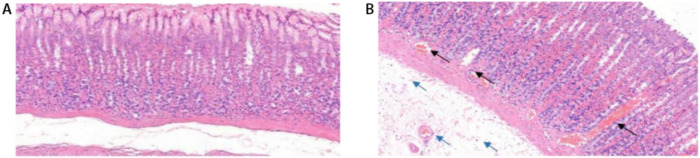
HE staining pathological sections.A. HE Staining Pathological Sections of Gastric Mucosa in the Control Group (×200); 2-B: HE Staining Pathological Sections of Gastric Mucosa in the Model Group (×200).